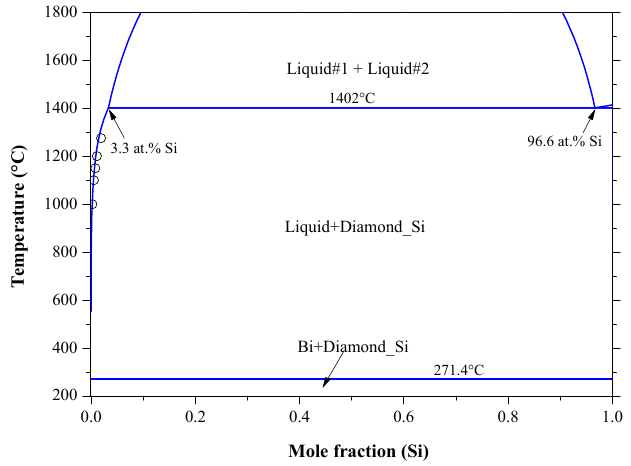
Figure 14. The calculated Bi-Si phase diagram [124]; ○ : [120].